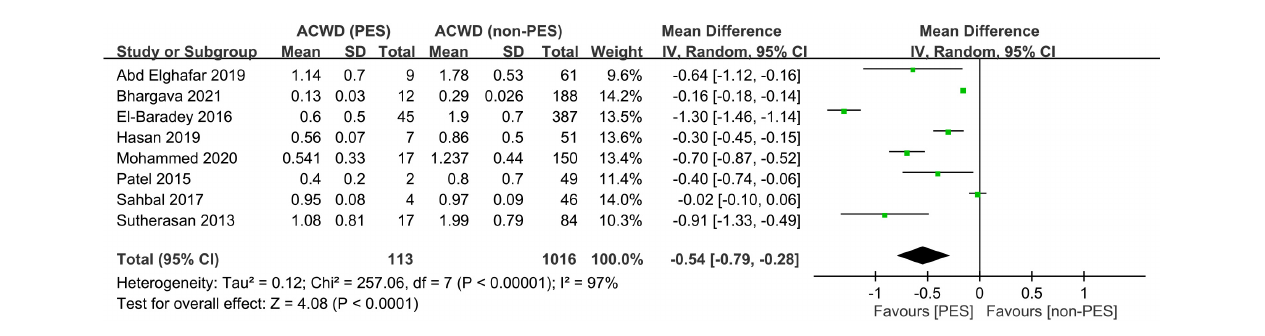
FIGURE7 Forest plot comparing the air column width difference (ACWD) between patients with and without post-extubation stridor (PES). CI, confidence interval.